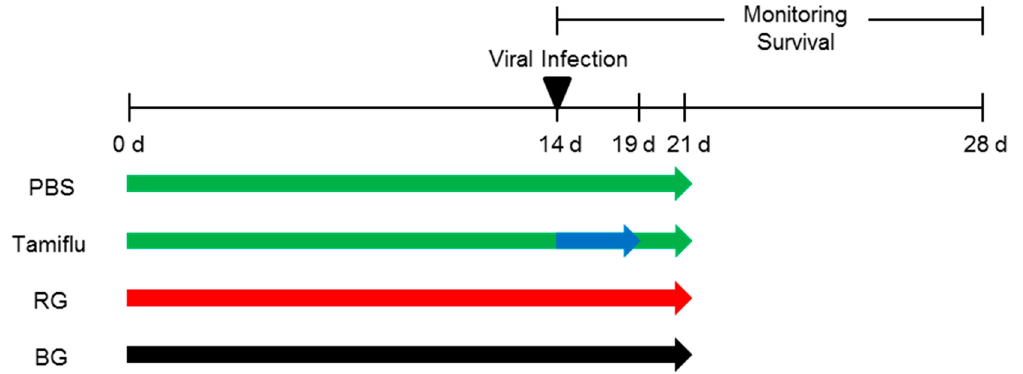
Figure 2. Schematic diagram of animal experiments. Mice were orally administered either red ginseng (RG) or black ginseng (BG) (10 mg/kg bw daily) for 14 days. After challenge with A/California/04/2009 virus, mice continuously received either RG or BG for an additional week. As a negative control, mice that received phosphate buffered saline (PBS) daily for 14 days were also infected with virus. The positive control group was treated with Tamiflu daily for 5 days post-infection and then with PBS for 2 additional days. All mice were monitored for 14 days post-infection to measure survival.